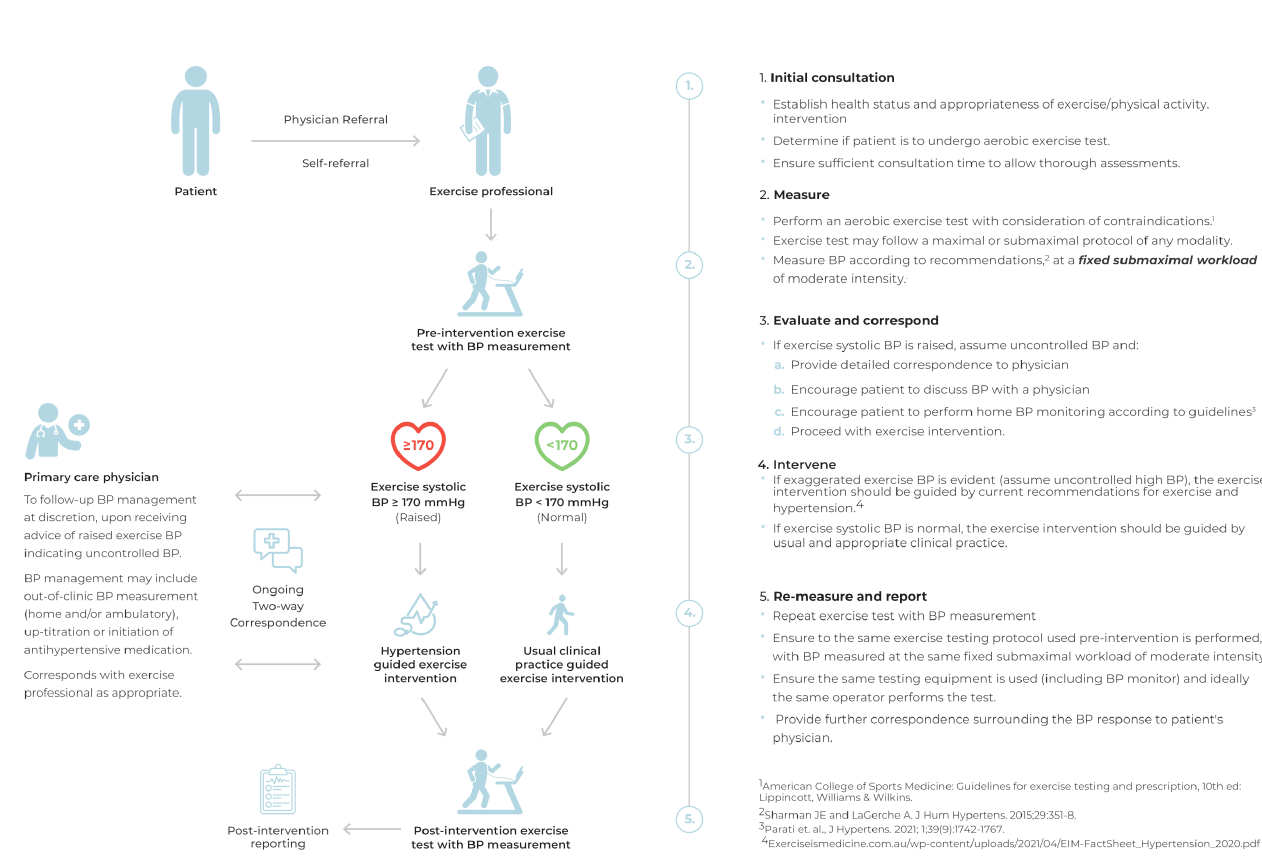
Figure 1. Pathway to identify and control high blood pressure in clinical exercise